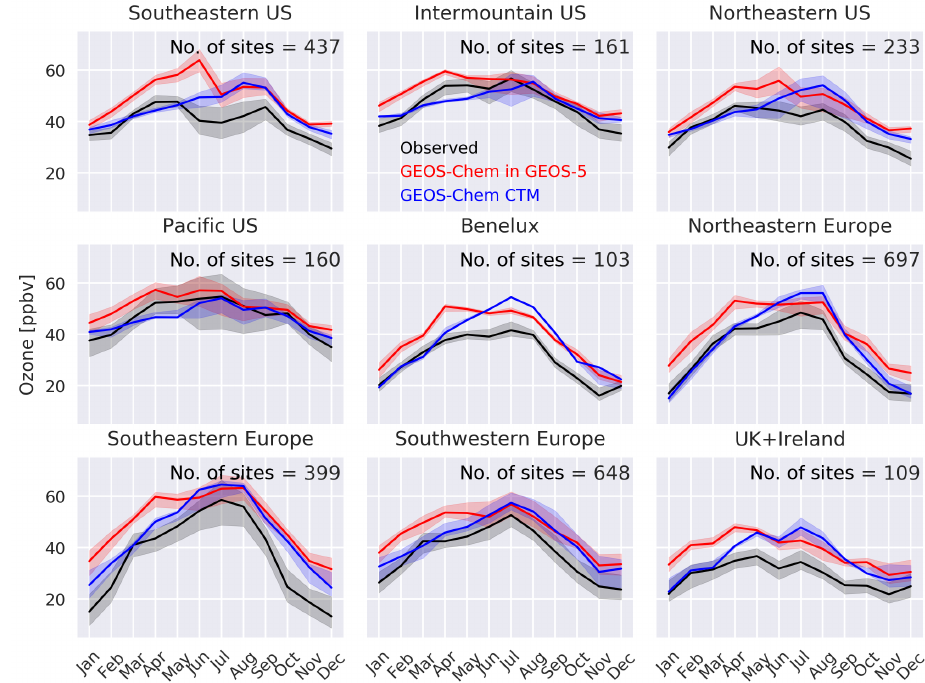
Figure 7. Monthly median afternoon (12:00–16:00LT) ozone concentrations (ppbv) for 2013–2014 at surface sites in the US and Europe, with interquartile range shaded. Surface monitoring sites are grouped according to Fig. A2. Also shown are the GEOS-5 Nature Run with GEOS-Chem chemistry (red) and the offline GEOS-Chem CTM (blue). Hourly model outputs are sampled for the locations and time of observations at the surface (lowest)